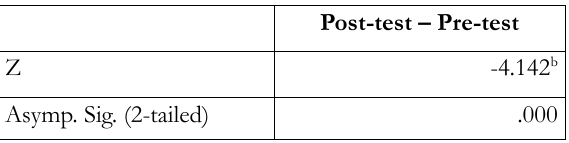
Table 17. Wilcoxon signed-rank tests